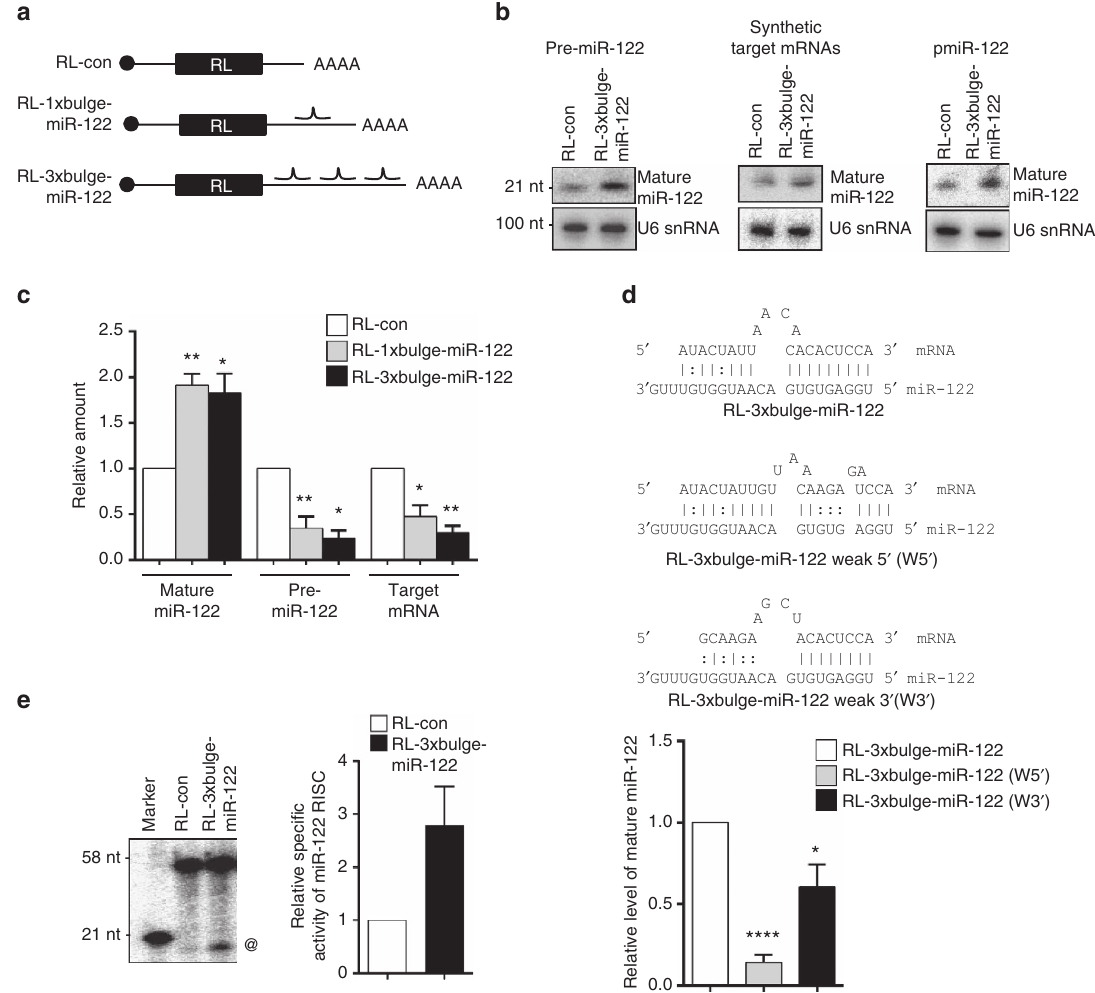
Figure 2 | Target mRNA-dependent increase of mature miR-122 in human cells. ( a ) Scheme of the different target mRNAs used. Positions of the miR-122-binding sites are indicated. ( b ) Effect of RL-3 (cid:2) bulge-miR-122 on mature miR-122 level in cells transfected with pre-miR-122 and reporter plasmids or in vitro -transcribed mRNAs. In experiment described in the right panel, HEK293 cells co-transfected with plasmid encoding pre-miR-122 (pmiR-122) and RL reporters were used. Total RNA was extracted and northern blotted for mature miR-122, for all the experiments. U6 snRNA was used as loading control. ( c ) Mature miR-122, pre-miR-122 and target mRNA levels were quantified by quantitative reverse transcriptase–PCR in HEK293 cells expressing target mRNAs and co-transfected with plasmid encoding pre-miR-122. ( d ) Effect of modification of 5 0 or 3 0 miR-122-binding site on target mRNA-driven miRNA elevation. Relative quantification of mature miR-122 level increase in the presence of target RL-3 (cid:2) bulge-miR-122 mRNA and in the presence of mRNAs with weak 5 0 - region (W5 0 ) or weak 3 0 -region (W3 0 ). Relative levels were normalized against respective target mRNA levels. ( e ) In vitro RISC cleavage assay done with protein equivalent amounts of affinity-purified FH-AGO2 isolated from pre-miR-122-transfected FH-AGO2 stable HEK293 cells expressing RL-3 (cid:2) bulge-miR-122 or RL-con. @, Cleaved product of RISC assay; radio labeled 21-nt band serves as a marker. Paired two-tailed Student’s t -tests were used for all comparisons. * P o 0.05, ** P o 0.01 and *** P o 0.001. Values plotted are means from at least three biological replicates for c and d , and two biological replicates for e . Error bars represent